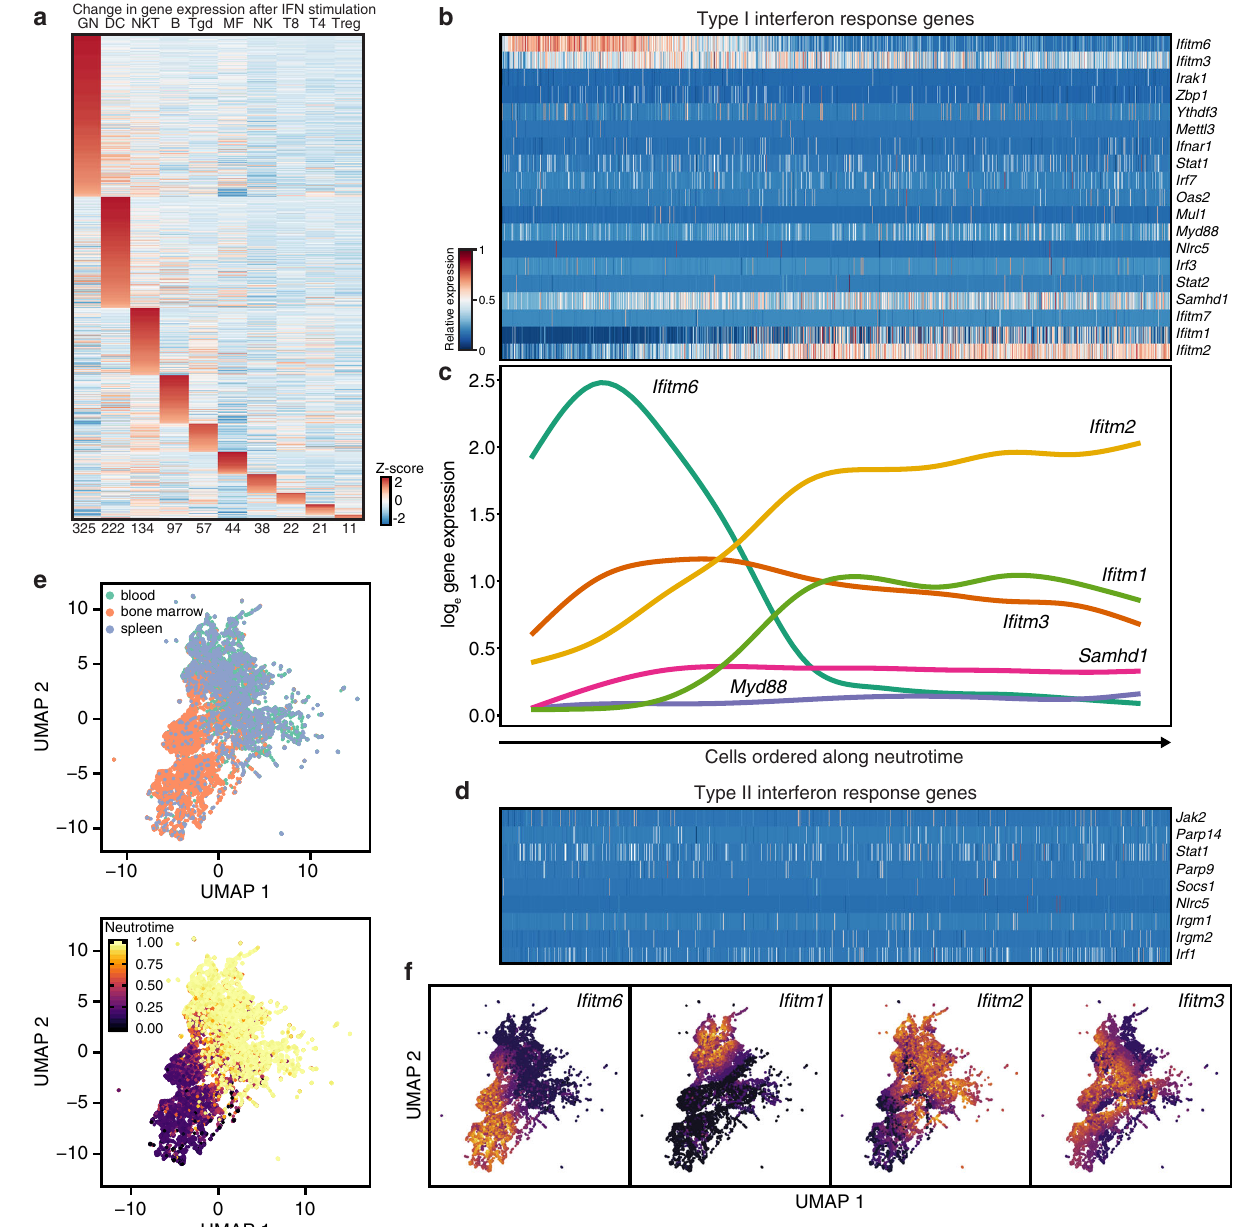
Fig. 4 Expression of interferon-related transcripts in neutrophils. a Response of 10 ImmGen populations to in vivo interferon α administration highlights marked transcriptional shift in neutrophils. b , c Expression of transcripts associated with type I interferon response along neutrotime. Cells are ordered along the x axis as in Fig. 2g. d Expression of transcripts associated with type II interferon response along neutrotime. e UMAP clustering of neutrophils based exclusively on transcripts associated with type I interferon response. f Expression of transcripts associated with type I interferon response mapped onto the UMAP